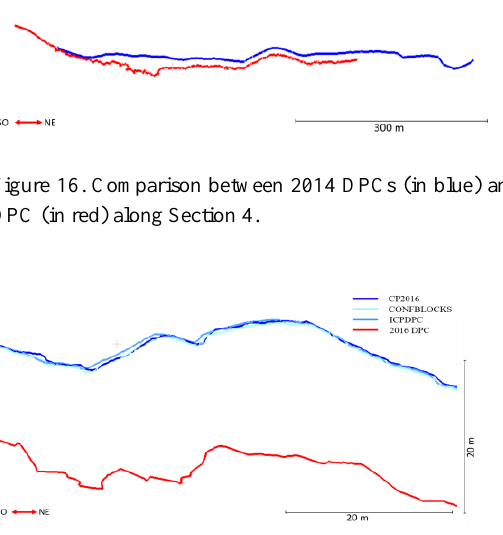
Figure 17. Comparison between Section 2 obtained from three 2014 DPCs (in different tones of blue) and 2016 DPC (in